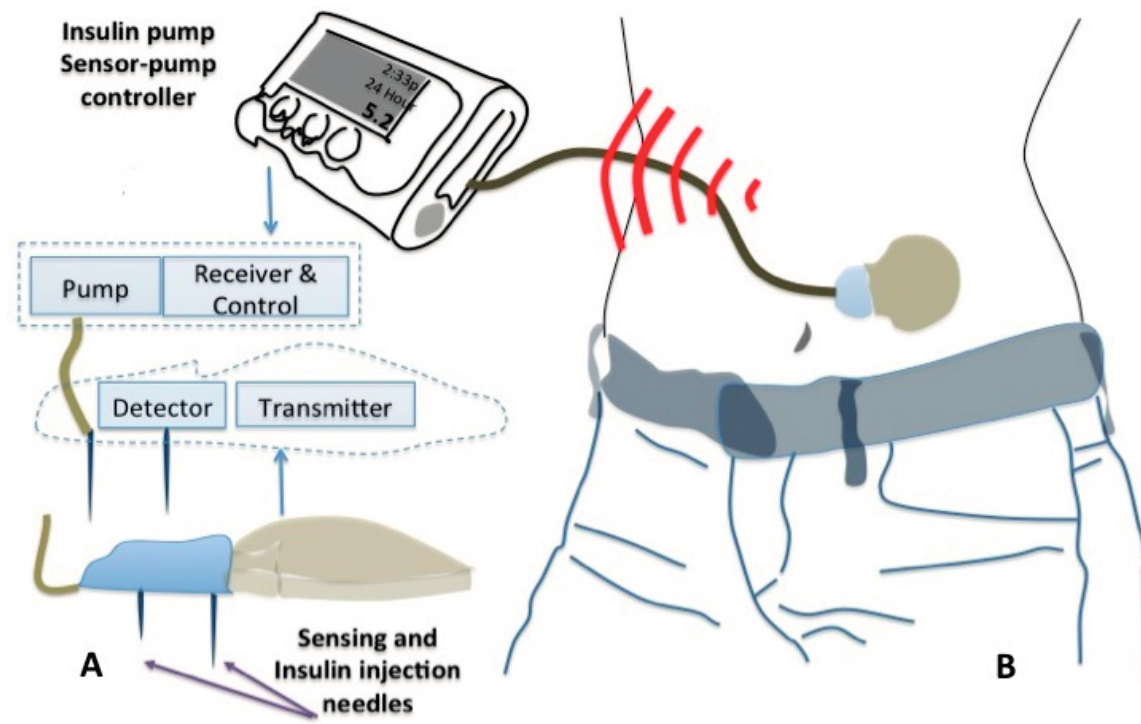
Figure 3. State of the art Implantable devices for diabetes POC applications, ( A ) a simplified diagram of implantable glucose monitoring and insulin injection and ( B ) a schematic of closed loop POC